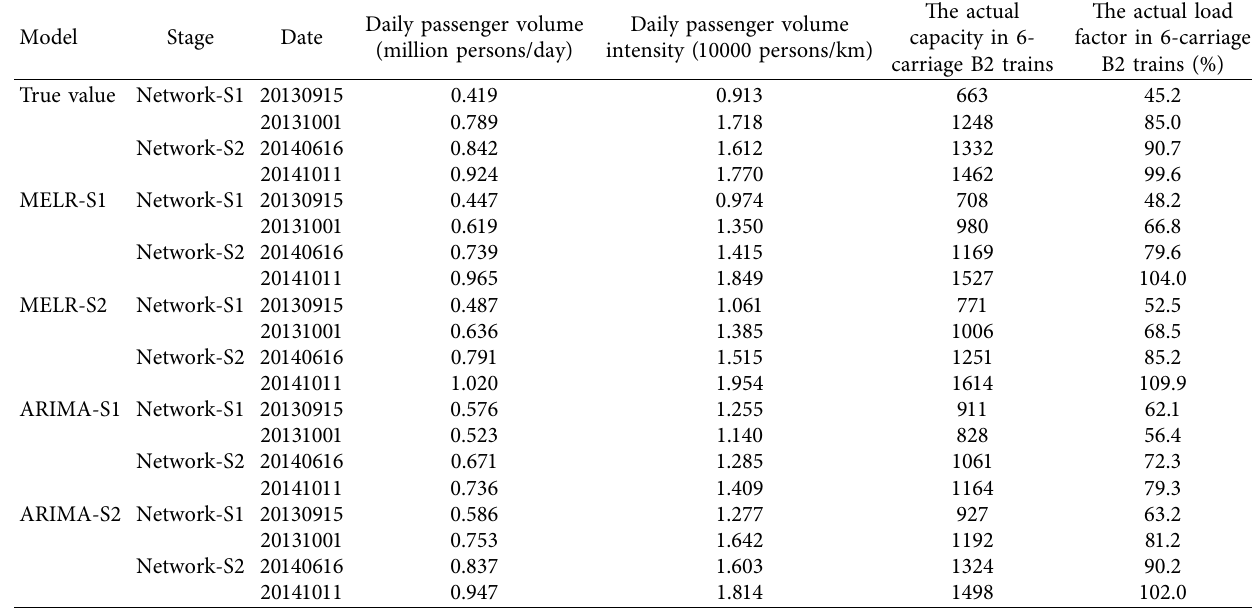
Table 7: The comparison of daily passenger volume and intensity on special days.